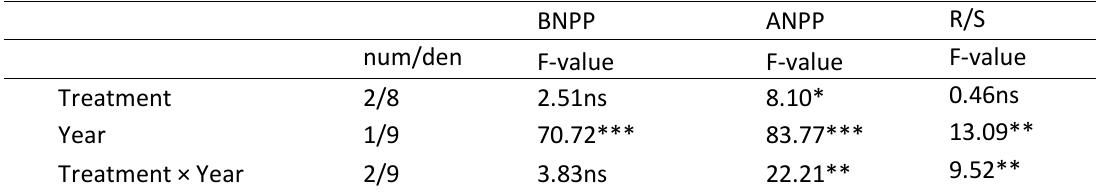
Table 3 . Repeated measure ANOVA is shown for treatment, year and interaction effects on annual root production (BNPP, g m -2 y -1 ), annual above-ground production (ANPP, g m -2 y -1 ) and root to shoot ratio (R/S). Numerator (num), denominator (den) of degree of freedom (DF), F values are